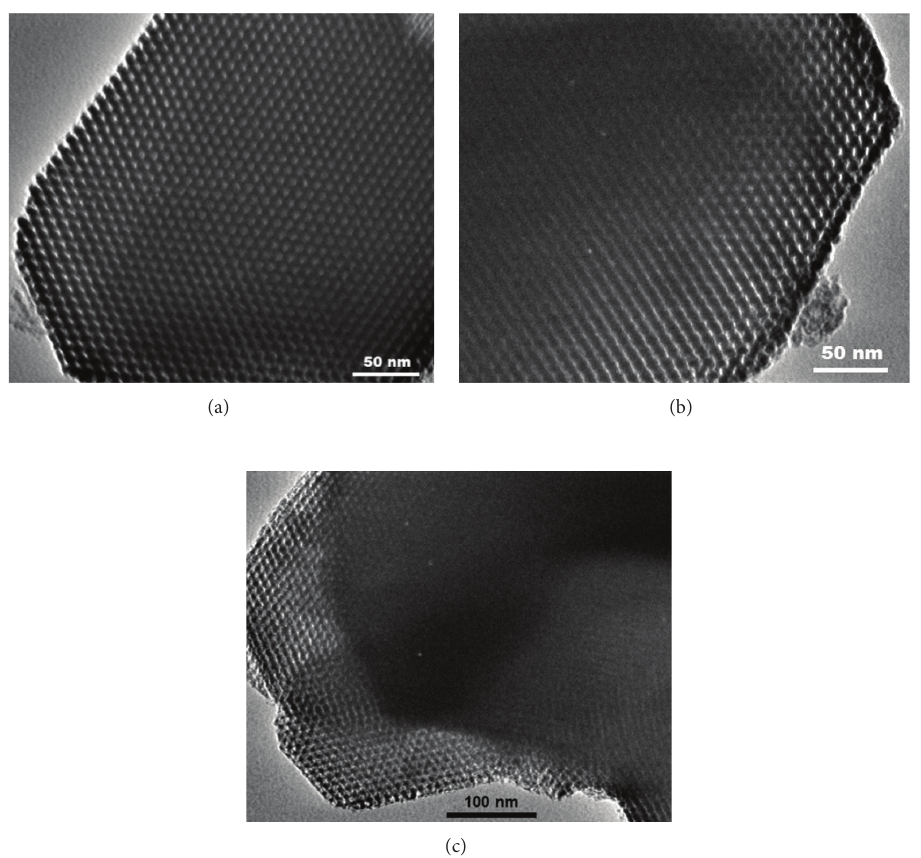
Figure 2: TEM images of the pure SBA-15 (a), TiO 2 -SBA-15 (b), and N-TiO 2 -SBA-15 (c).